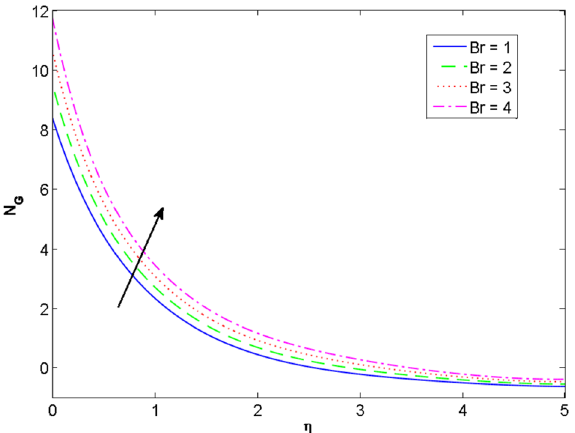
Figure 15. Profile of N G versus Br .